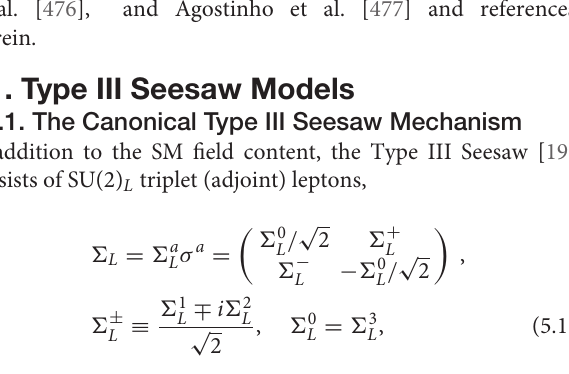
) plane to the processes shown in Figure 32 after L R